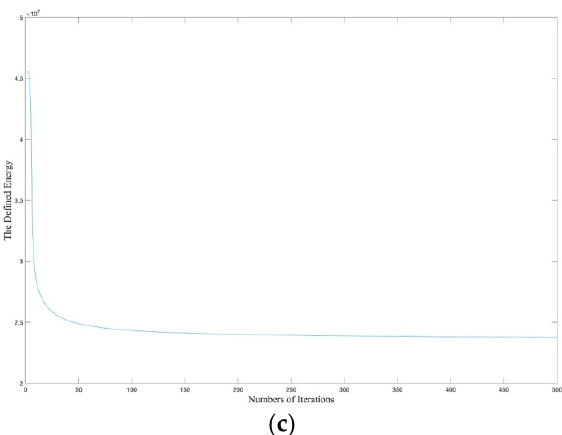
Figure 2. ( a ) The segmented results were illustrated by applying the proposed approach. The regional constants are 28.75, 28.55, 28.98 and 29.12, respectively. Similarly, (cid:2026) (cid:3036) are 0.062, 1.487, 0.648 and 7.755 respectively. ( b ) The estimated shadow effects were approximated by the proposed approach. ( c ) The convergence was illustrated by applying the proposed approach.